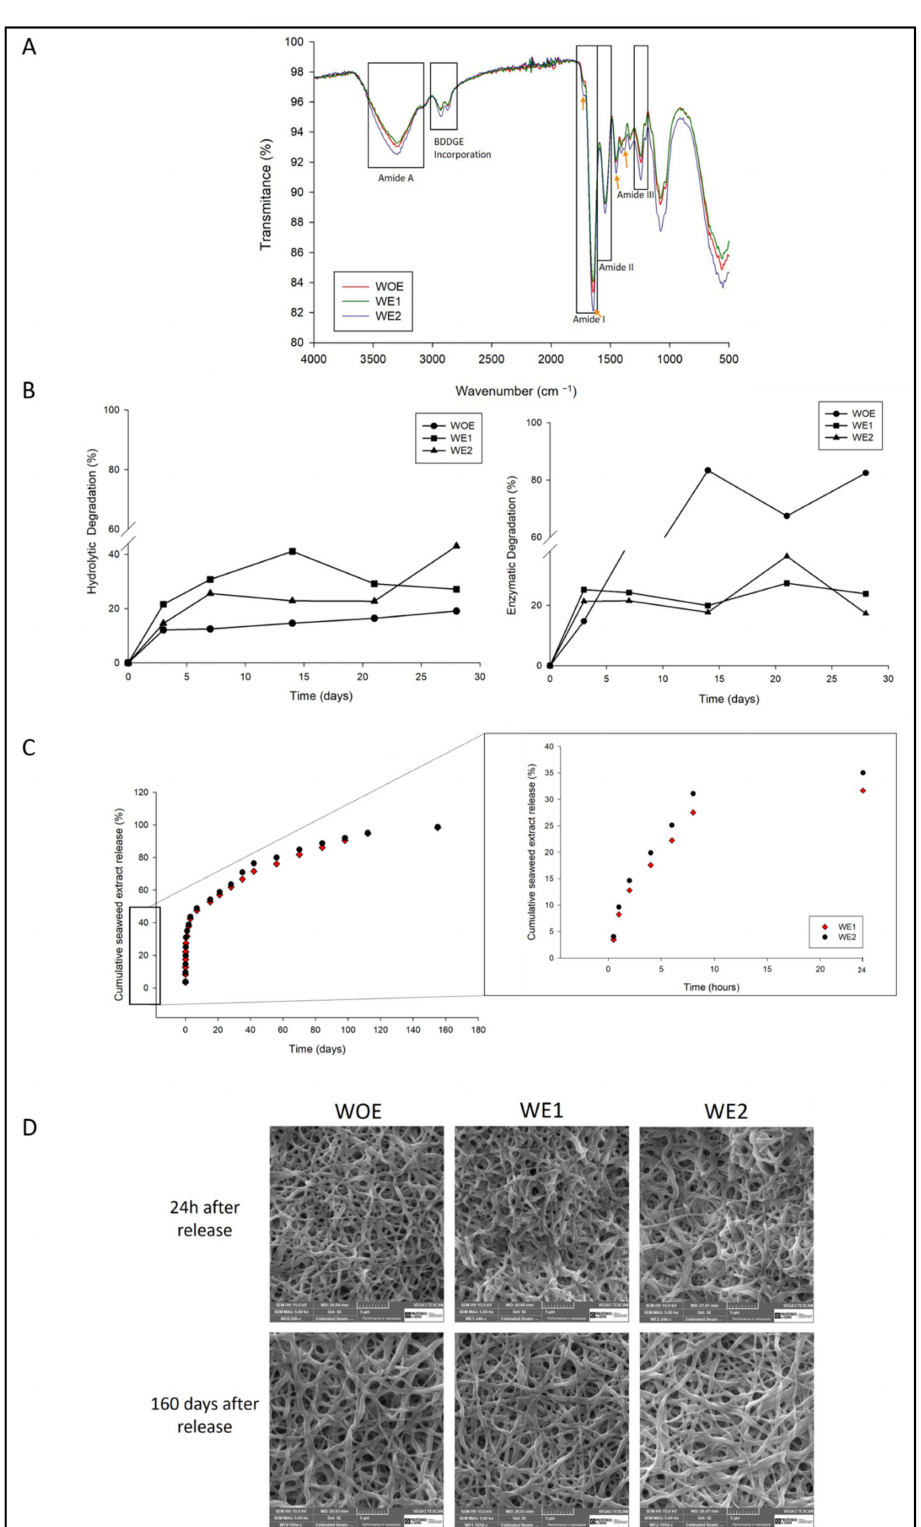
Figure 2. ( A ) FTIR spectra of WOE mesh (red line), WE1 mesh (green line) and WE2 mesh (blue line). The orange